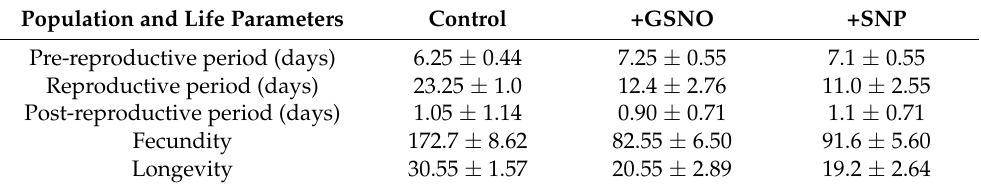
Table 1. Mean developmental time, longevity, total fecundity and rate of development of A. pisum on P. sativum seedlings exposed to pretreatment with an NO donor or with no pretreatment (control) ( n = 20). Hypotheses on equality of means were verified by the two-sample t -test (Table S1).